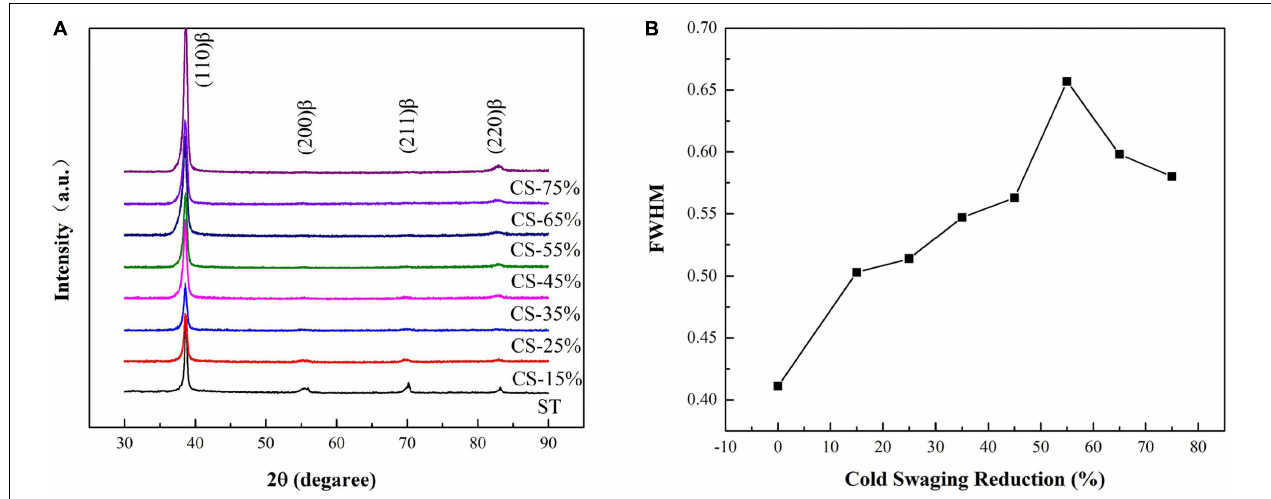
FIGURE 1 | (A) XRD profiles of the Ti-10Mo-6Zr-4Sn-3Nb alloy solution annealed at 790 ◦ C/1 h, water quenching and cold deformed with reductions of 15, 25, 35, 45, 55, 65, and 75%; (B) The relationship between cold swaging reduction and full width half maximum (FWHM) of (1 1 0).